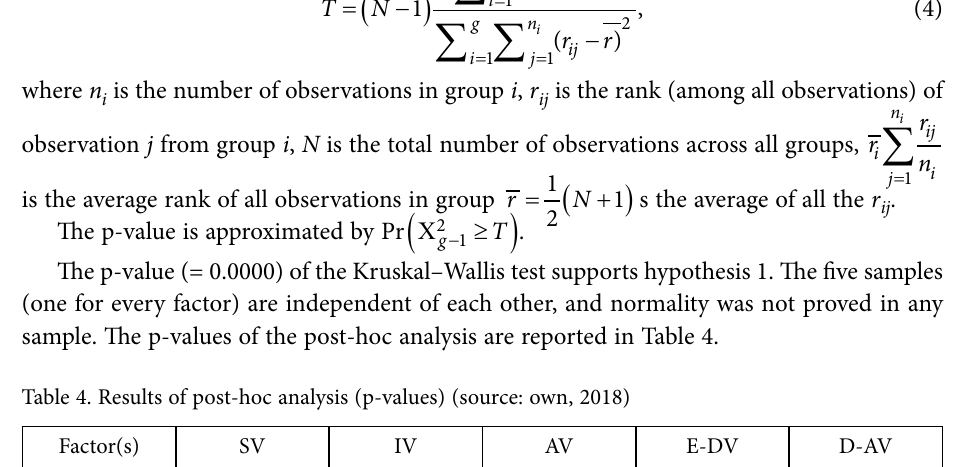
Table 4. Results of post-hoc analysis (p-values) (source: own, 2018) Factor(s) SV IV AV E-DV D-AV SV − 0.000000 0.000000 0.000000 0.000000 IV 0.000000 − 0.000003 1.000000 0.000000 AV 0.000000